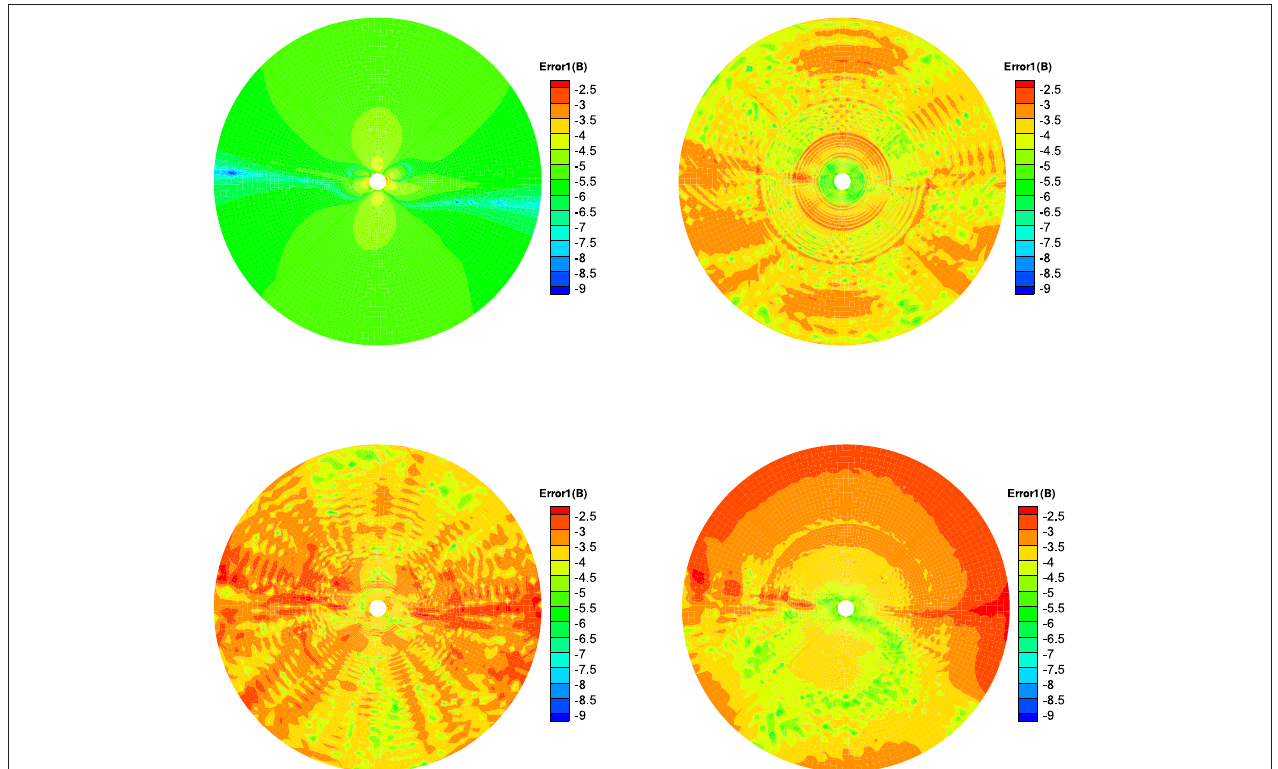
FIGURE 10 | The log 10 Error1 (B) in the calculation at t = 20 h on the meridional plane of φ = 180 ◦ − 0 ◦ from 1 to 20 R s , the results from CT method (left) and diffusive method (right) are displayed in the top row, the bottom row is provided by the projection method (left) and GLM method